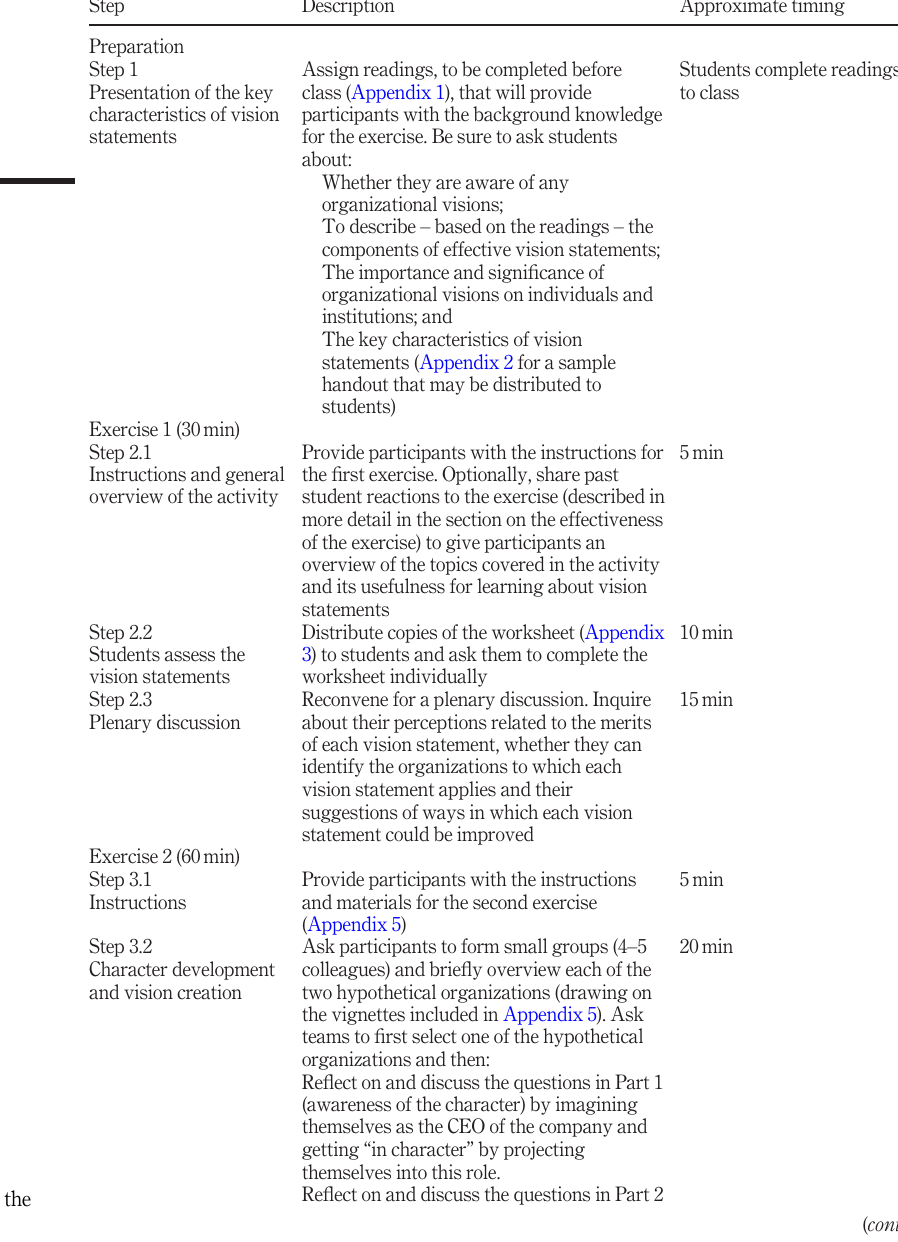
Table 1. Steps to run the